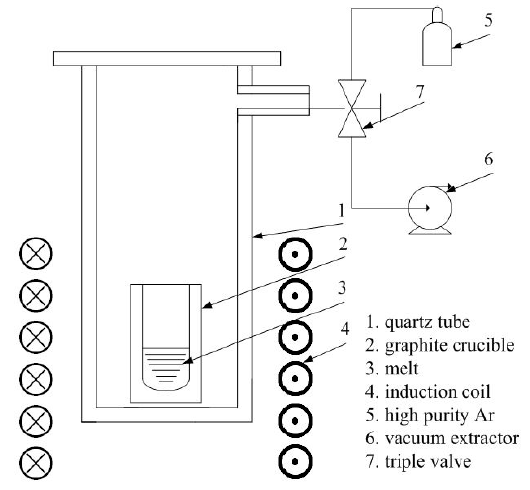
Figure 1. Sketch map of the melting device.